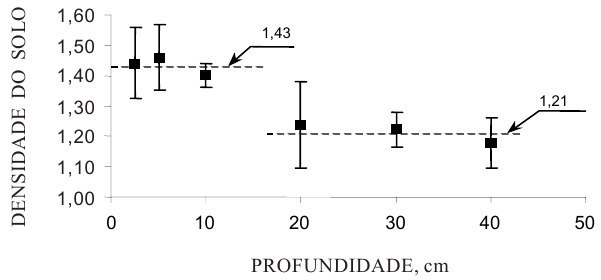
Figura 1. Perfil da densidade do solo. O perfil evidencia duas